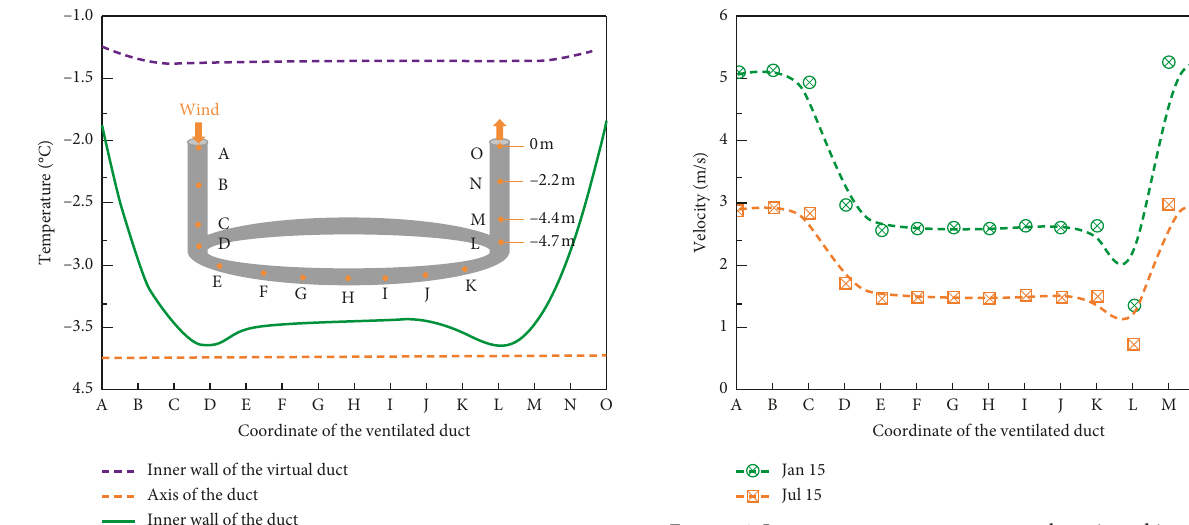
Figure 4: Instantaneous temperatures at the axis and inner wall of the duct on January 15 and July